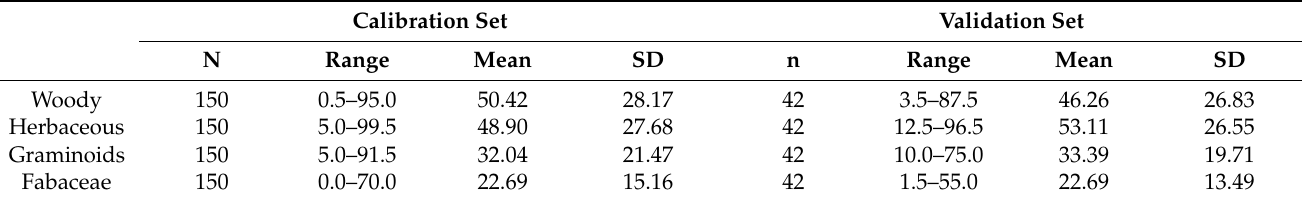
Table 1. Plant species composition (%) of Pyrenean chamois fecal samples used in the calibration and validation sets. Calibration Set Validation Set